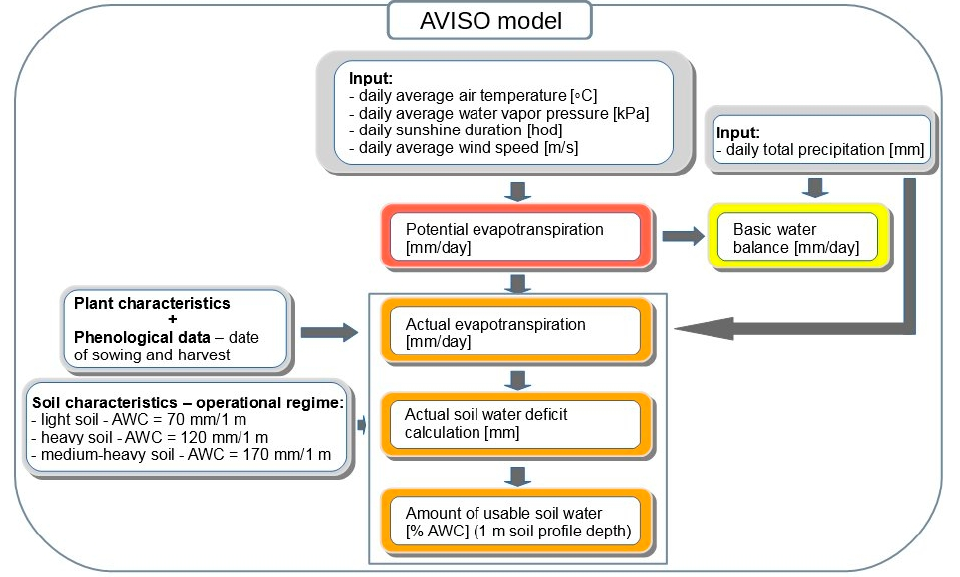
Figure 2. Scheme of data processing in the AVISO agrometeorological model.